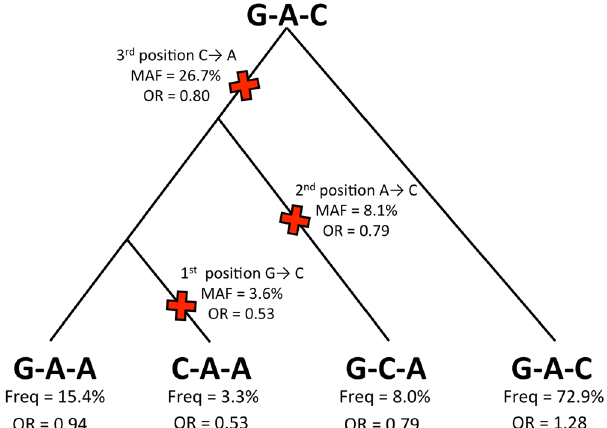
Figure 1. TYK2 variants and haplotypes analyzed in this study. The figure shows the most parsimonious ancestry for the four most common TYK2 haplotypes (frequency > 0.5%). The TYK2 gene tree is rooted at the ancestral G-A-C haplotype with red “X”’s indicating the most parsimonious history of mutation events giving rise to the three independently associated psoriasis SNPs rs34536443 G > C, rs12720356 A > C, and rs2304256 C > A. The ancestral allele at each SNP was determined using the UCSC Genome Browser and in each case agreed with the major allele. The three SNPs are presented in chromosomal (p → q) order on the plus strand, which corresponds to C-terminal to N-terminal order in the TYK2 gene. The minor/protective allele frequency (MAF) and single marker odds ratio (OR) are shown for each SNP. Frequencies and odds ratios are also shown for each